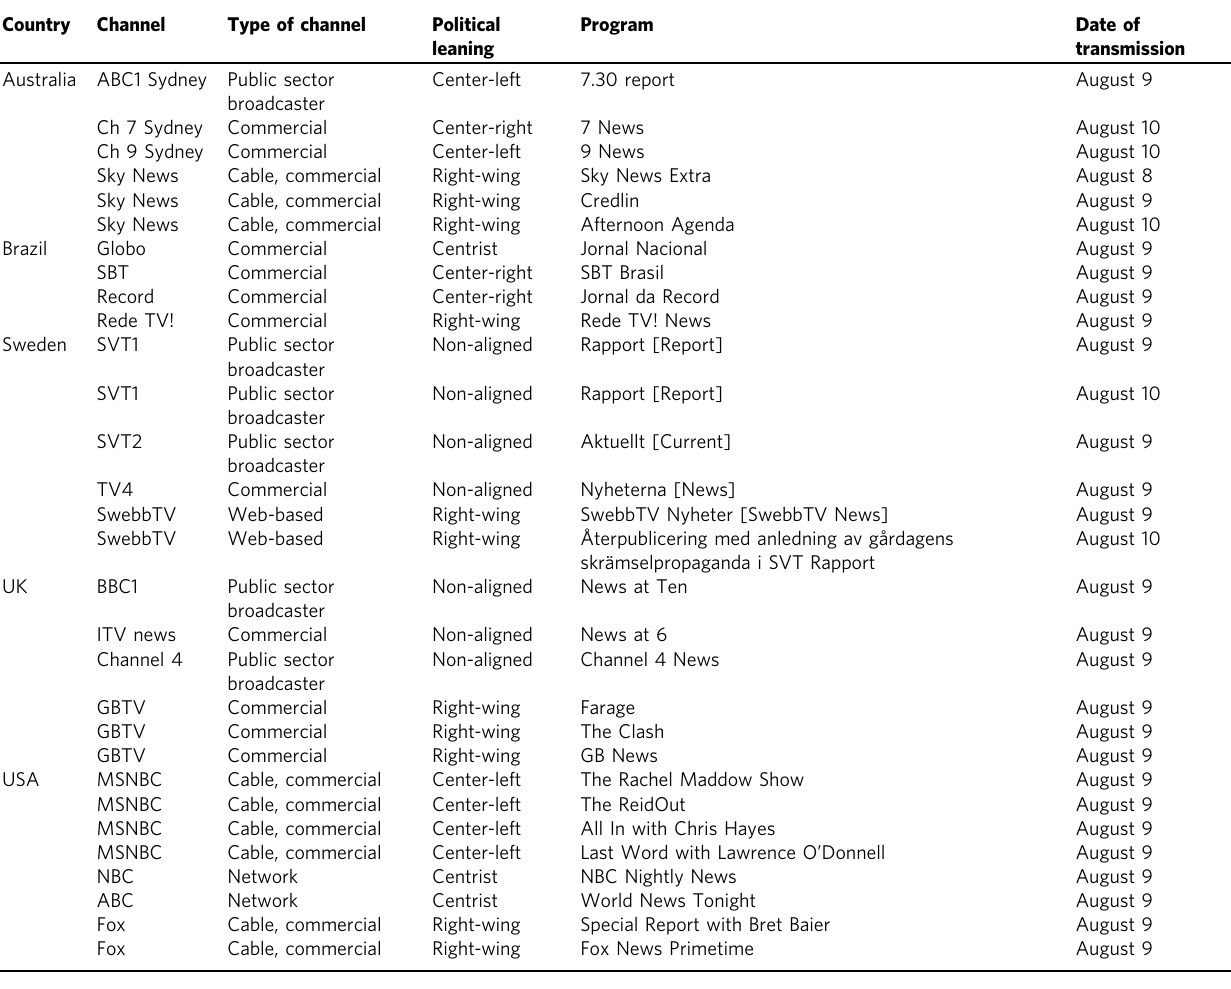
Table 1 Television channels and programs monitored, by country and political leaning. Country Channel